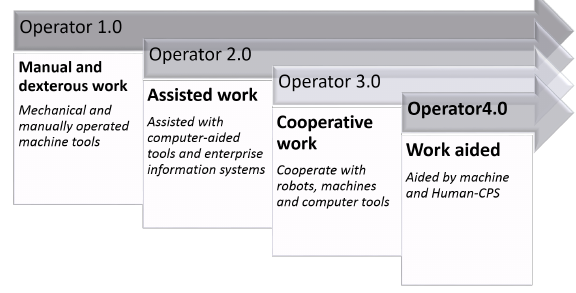
Figure 1. (R)evolution of the tasks of operators in manufacturing systems. Table 1. Elements of the Operator 4.0 methodology according to